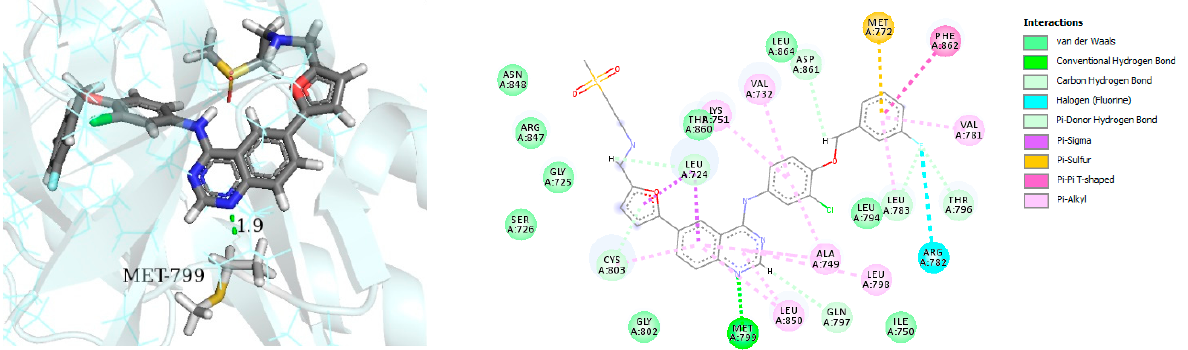
Figure 4. Best-docked pose of Lapatinib within the HER4 (ErbB4) active site, where hydrogen bond interactions are shown as green dashed lines ( left panel ) and its corresponding detailed 2D-interactions map ( right panel ). This docking study was conducted by us, no copyright issues.